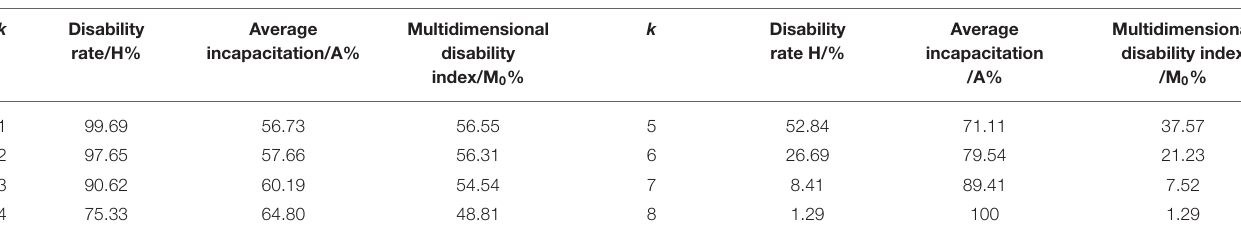
The contribution rate (%) of M 0